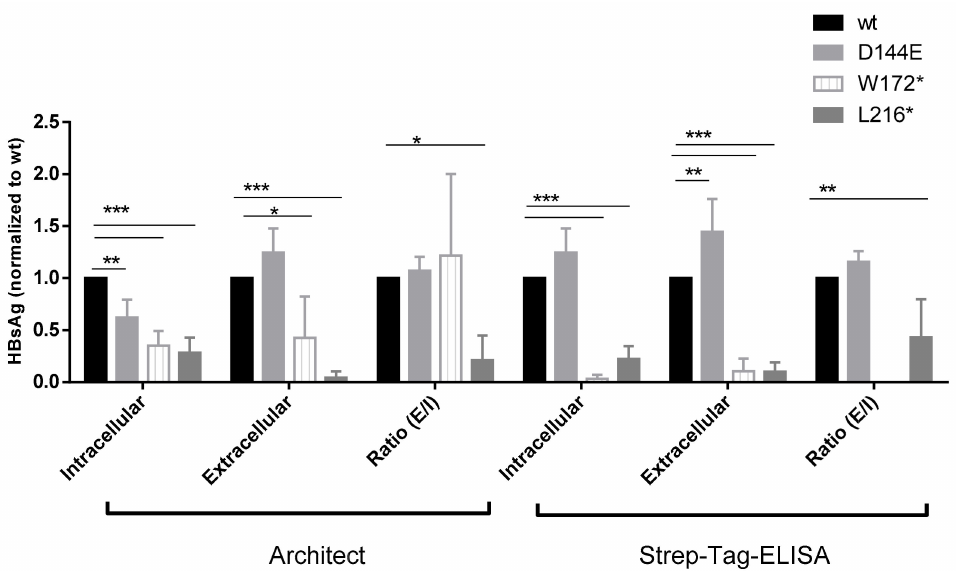
Figure 4. HBsAg production, secretion, and recognition of viral particles harboring HBsAg variants. Huh7 cells were transfected with plasmids coding HBsAg wildtype (wt) or its variants. The HBsAg was measured in cell lysates and supernatant using Architect (Abbott) and Strep-tag ELISA. The HBsAg values for the mutants were normalized to the wt variant. The HBsAg production and secretion (intracellular and extracellular HBsAg) were compared between the wt vs. the SHB D144E, W172* and L216* variant. We detected significantly lower intracellular and extracellular concentrations of HBsAg in the case of the L216* and W172* mutant vs. wt. The extracellular to intracellular ratio of L216* was lower compared to that of the wt. Detection with Architect (Abbott) and Strep-tag-ELISA showed similar results. For the D144E mutant, we observed a modestly reduced intracellular HBsAg (measured with Architect) and a modestly increased extracellular HBsAg (measured with Strep-tag-ELISA) compared to the wt. The ratio of extracellular to intracellular HBsAg of the D144E mutant was comparable to that of the wt. The comparison between the HBsAg of wt and mutants was performed using one-way ANOVA with Dunn’s multiple comparisons test. Wt = wild type, E = extracellular, I = intracellular. * = p < 0.05, ** = p < 0.01, *** = p <